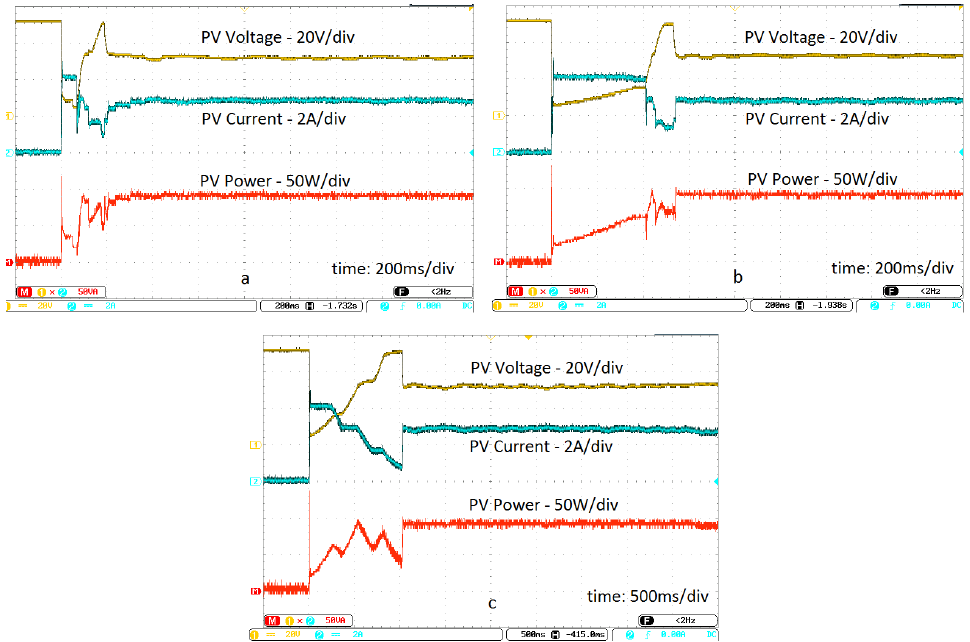
Figure 16. The results of the first PSC ( a ) Proposed algorithm; ( b ) Method in [7]; and, ( c ) Method in [28].